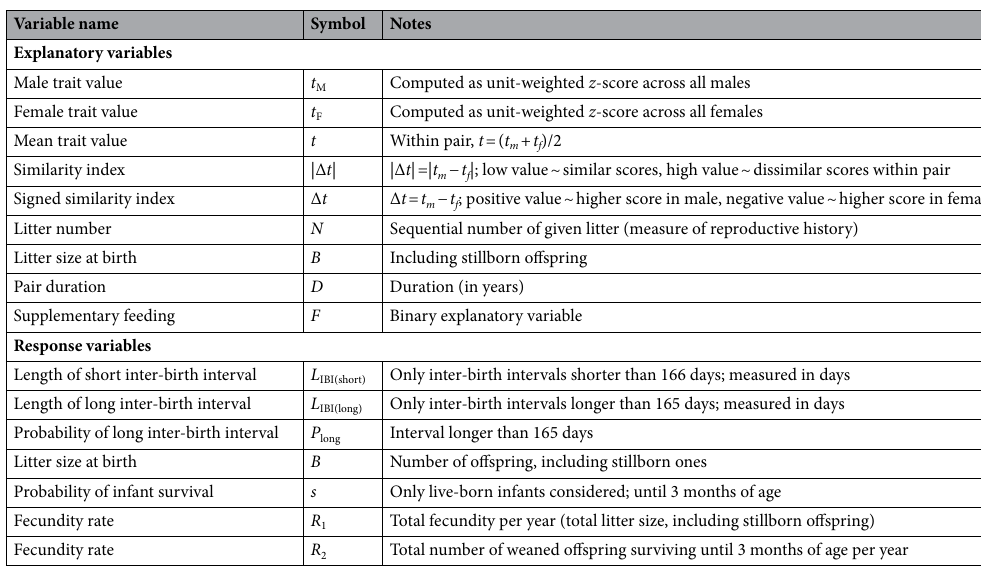
Table 2. Explanatory and response variables included in the models examining the links between personality traits and variables of reproductive success. t stands for the actual traits: Conscientiousness ( co ), Agreeableness ( ag ), Assertiveness ( as ), Patience ( pa ), Inquisitiveness ( in